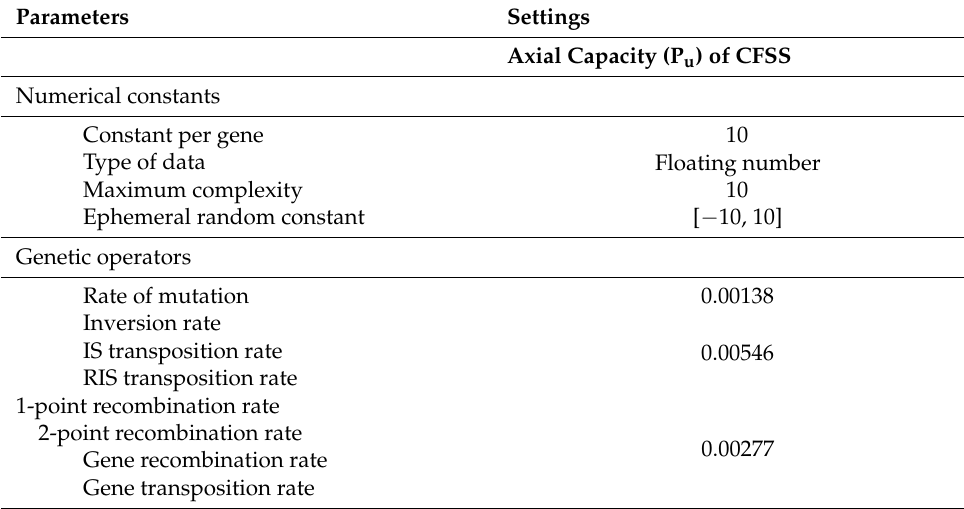
Table 3. Parameters setting for GEP algorithms.